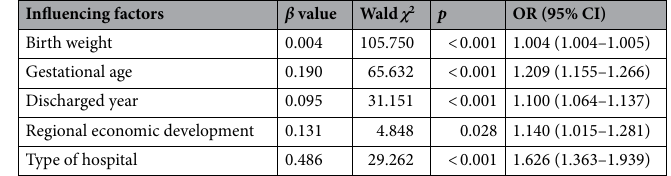
Table 5. Binary logistic regression analysis of influencing factors for survival rate.